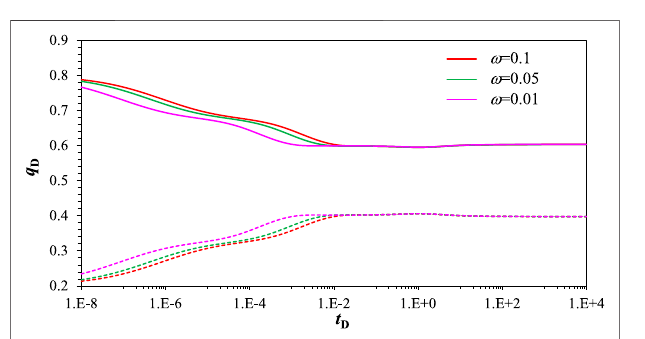
FIGURE 15 | Pressure transient response curve effected by fracture angle. ( C D = 1e-5, S =0.01, x asymD = 0.3, L F =150 m, C FD = 10, R e = 3000